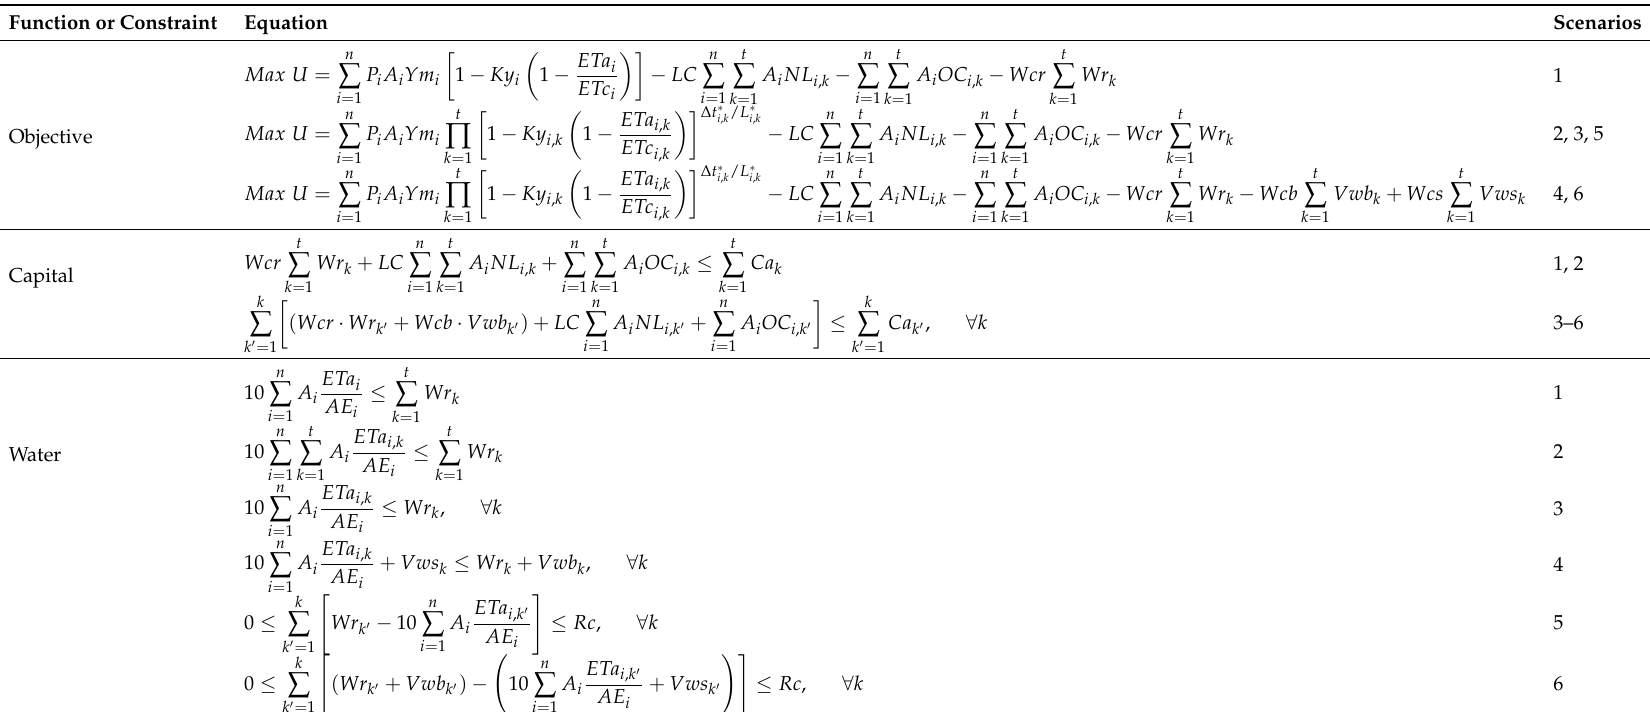
Table 3. Objective functions and constraints used in each